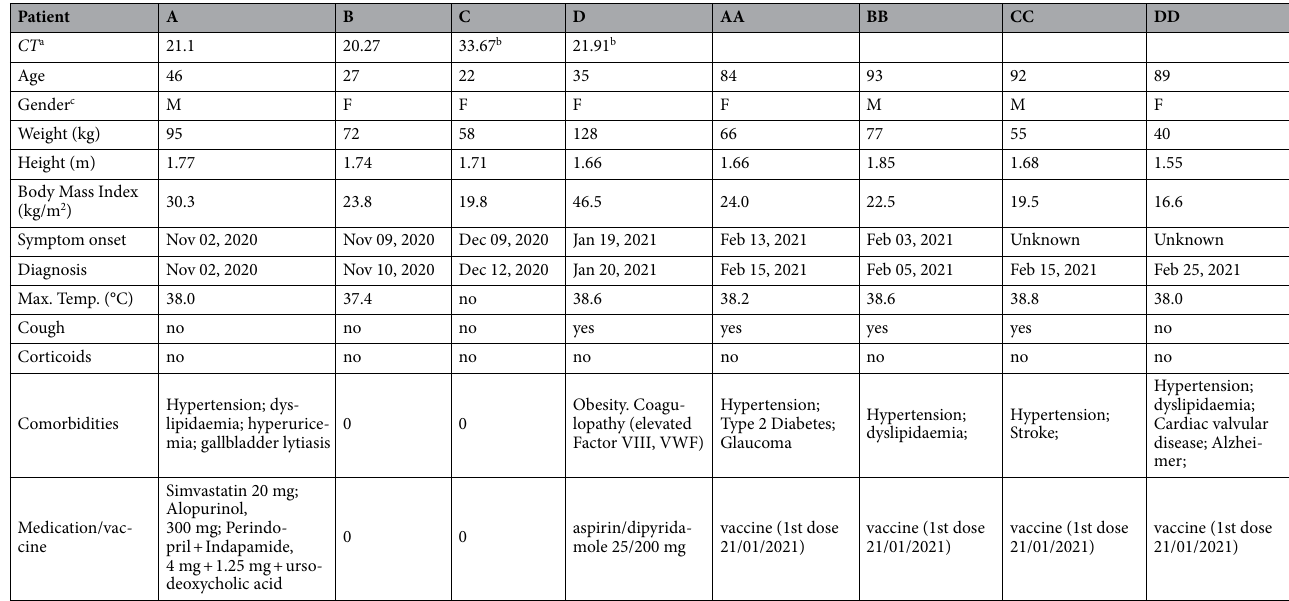
Table 3. Patients demographics and characterization. a CT for Gene E, exceptions are marked. b CT for Gene N. c Male—M or